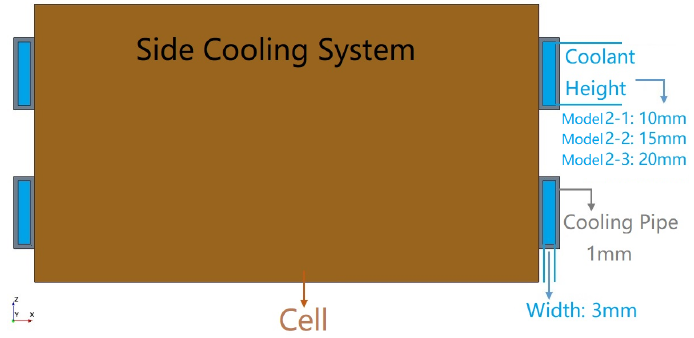
Figure 3. Cross-sectional area of the liquid tube models of the side cooling system.